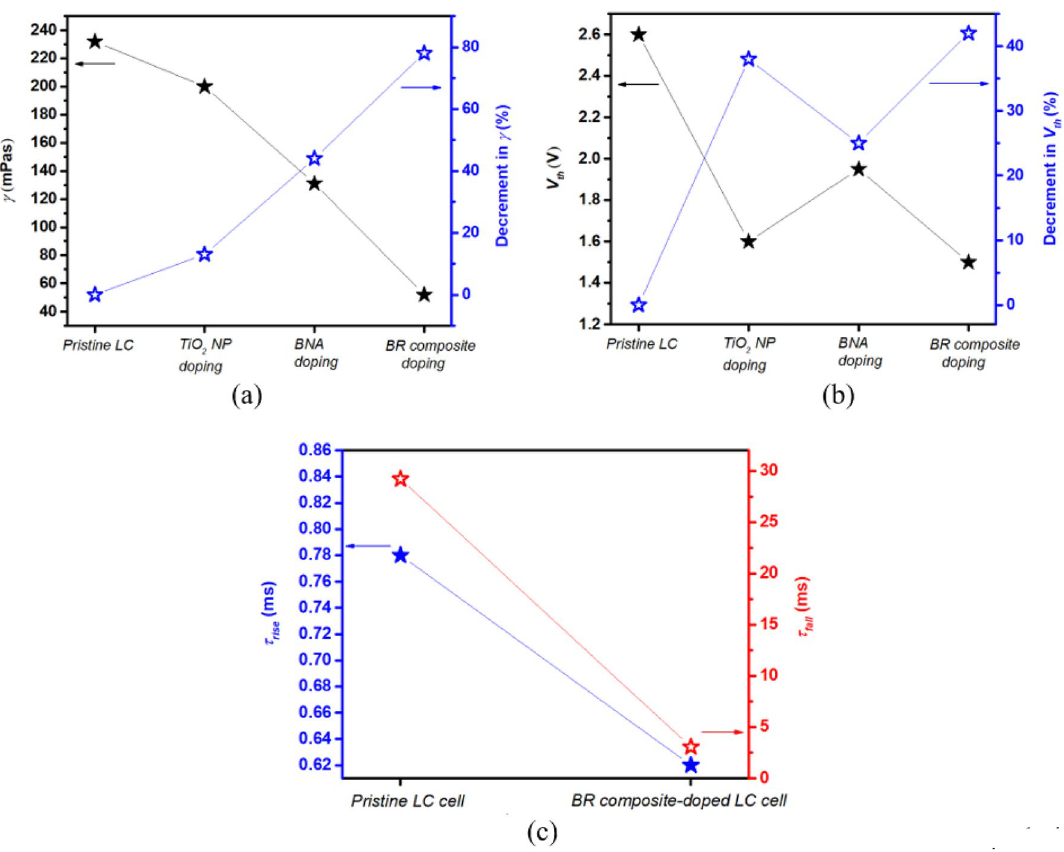
Figure 5. ( a ) γ and ( b ) V th of the LC cells by pristine LC, TiO 2 NP doping, BNA doping, and BR composite doping. ( c ) Response time of the pristine and BR composite-doped LC